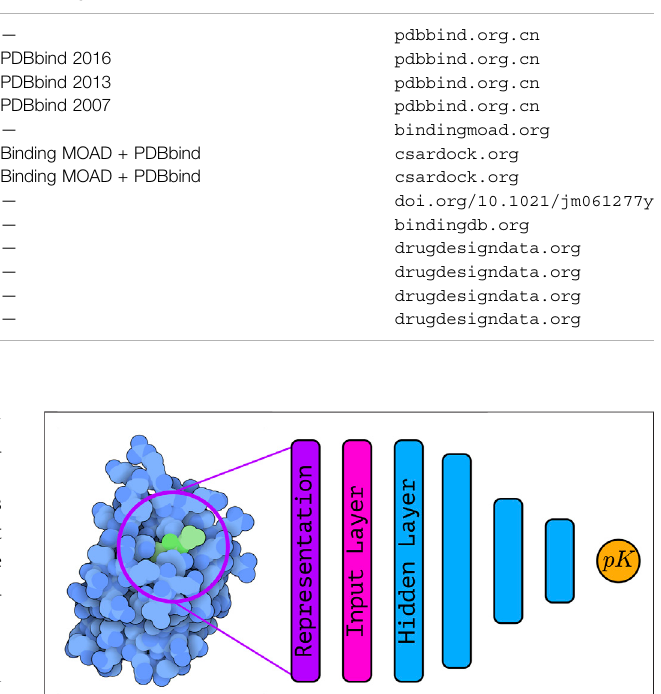
TABLE 1 | Main data sets providing protein-ligand complexes (crystal structures) and corresponding binding af fi nities. N is the number of protein-ligand complexes (co- crystal structures) with associated binding af fi nities. Data Set